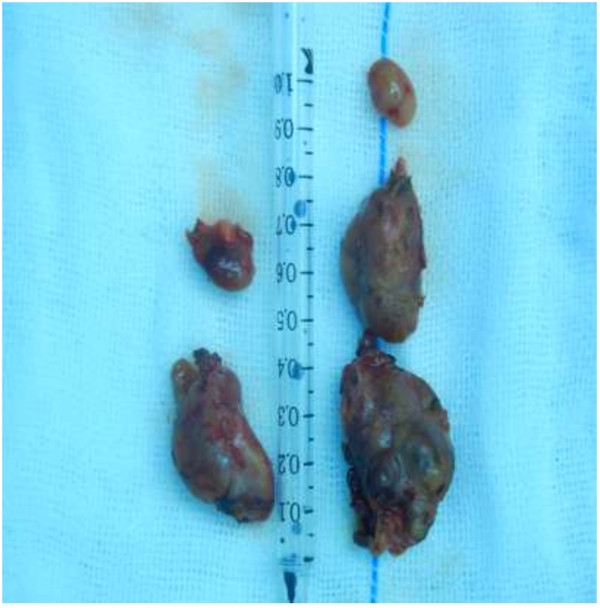
Five parathyroid glands identified at the primary operation in patient for secondary hyperparathyroidism.